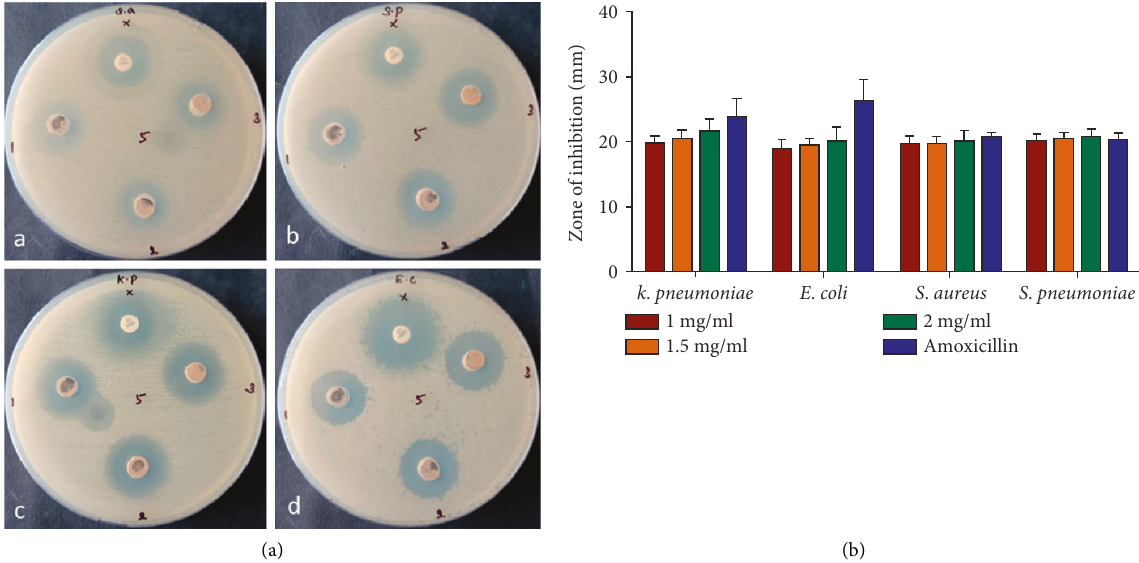
Figure 5: Antimicrobial effect of CuO-TiO 2 -chitosan-amygdalin nanocomposite. Bacterial strains tested in this investigation included Gram-positive and Gram-negative strains (a); S aureus (A), S pneumonia (B), K pneumonia (C), and E coli (D). CuO-TiO 2 -chitosan- amygdalin nanocomposites zone of inhibition quantitative measurements (b). Experiments were carried out in triplicate, values were expressed as mean ± SD, and typical photos are displayed